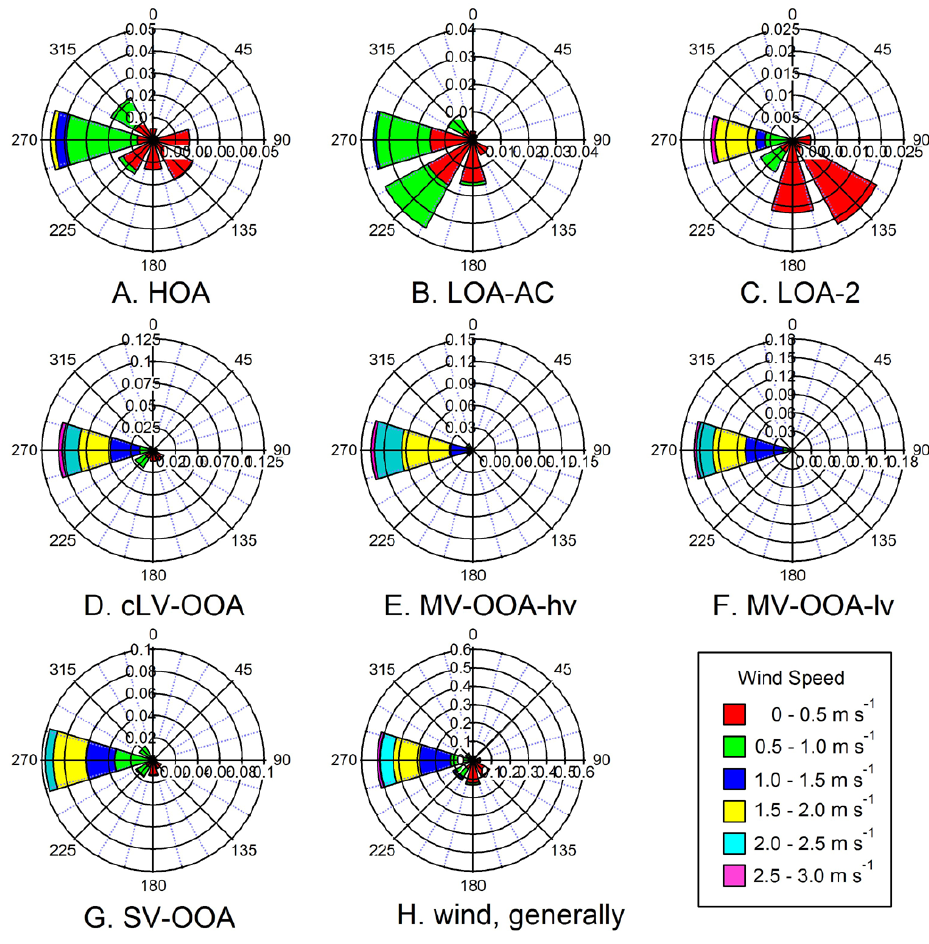
Fig. 9. Wind rose plots for OA components identified from the 7-factor TD-AMS-PMF solution.